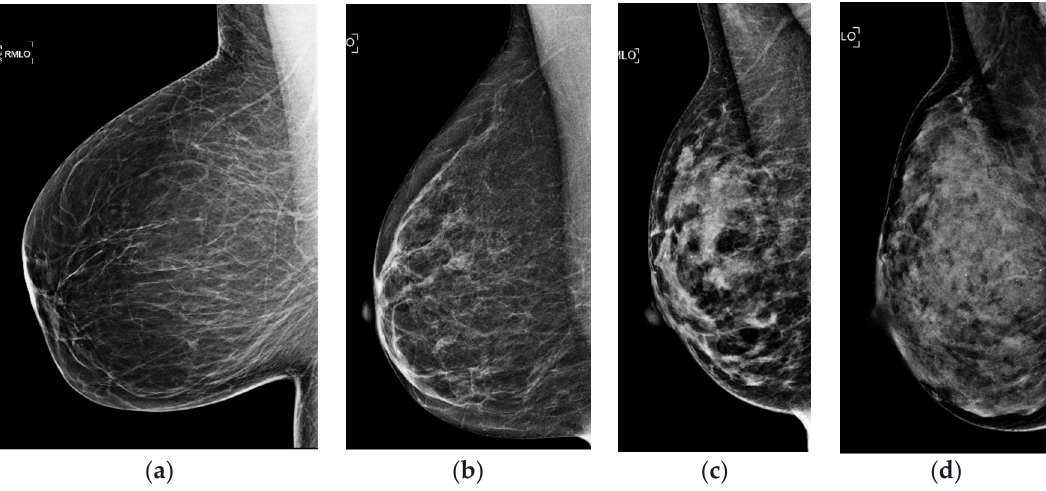
Figure 1. Breast density ( a ) almost entirely fatty, ( b ) scattered fibroglandular tissue, ( c ) heterogeneously dense, and ( d ) extremely dense, as determined by the BI-RADS Atlas [4]. Table 1. Tissue composition descriptions used in the BI-RADS Atlas [4].